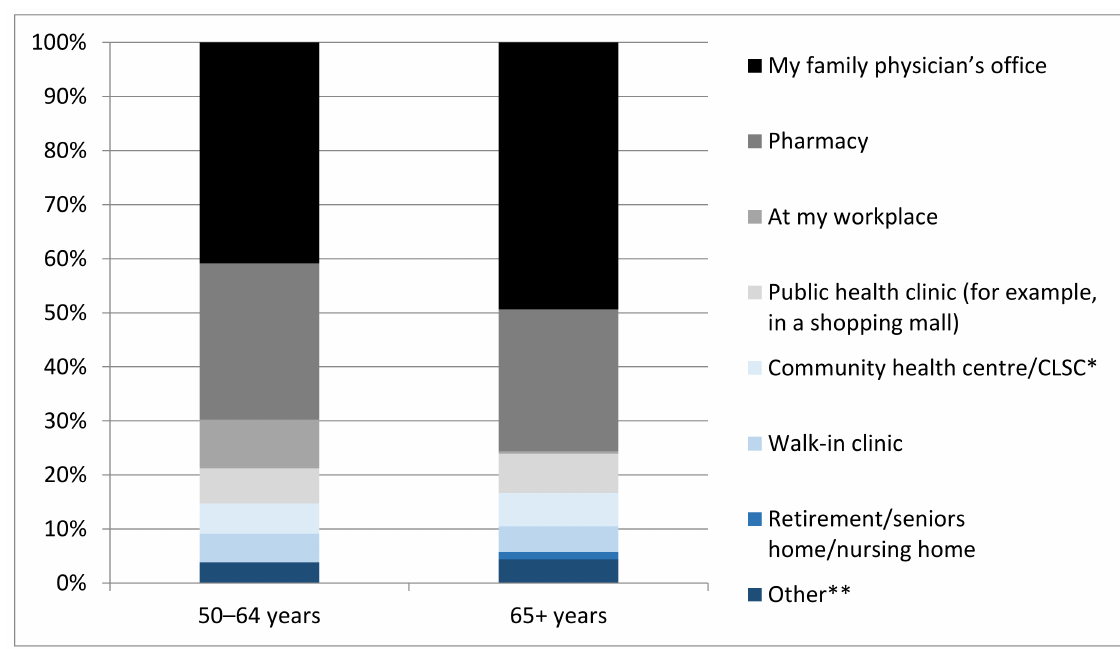
Figure 2. Preferred location to receive COVID-19 vaccine. * CLSC = Centre local de services communautaires (form of community health centre in Quebec). ** Other = undecided, no preference,